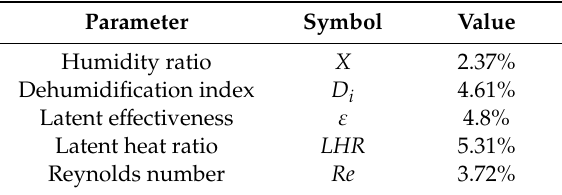
Table 3. Uncertainty